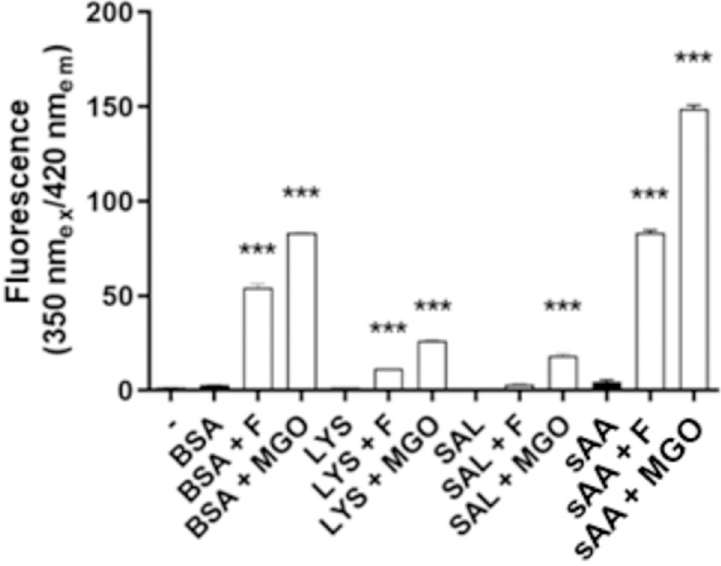
Fig 1. Fluorescence intensity of non-glycated BSA, LYS, SAL and sAA, and glycated by fructose or MGO. ��� p <